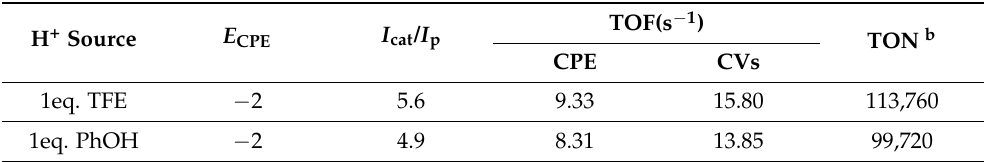
Table 3. Catalytic parameter for the CO 2 /CO reduction a